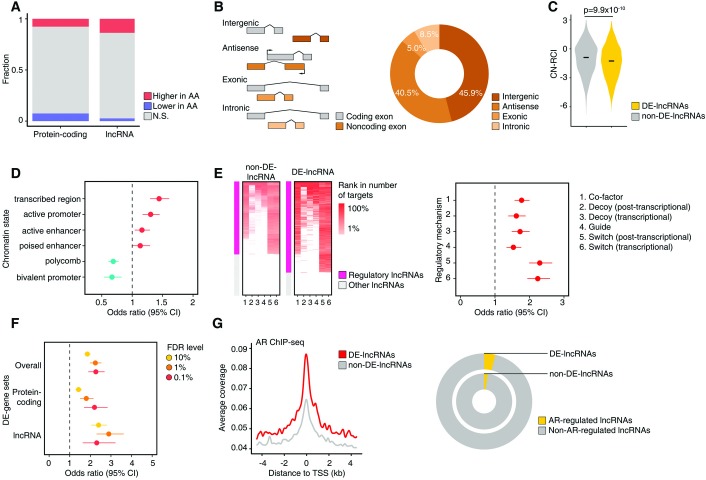
Comparison of the prostate tumor non-coding transcriptome by genetic ancestry.(A) Proportions of DE-protein-coding and DE-non-coding genes. Red indicates statistically significantly higher expression in AA, while blue indicates lower expression in AA. Width of bars is proportional to the number of genes. (B) Classification of lncRNAs by genomic location relative to protein-coding genes (left). Circle plot of distribution of DE-lncRNAs by lncRNA genomic location (right). (C) Distributions of cytoplasmic-nuclear relative concentration index (CN-RCI) for DE-lncRNAs and non-DE-lncRNAs. DE-lncRNAs are more enriched in the nucleus (lower CN-RCI). (D) Odds ratios and 95% confidence intervals (95% CI) of differential expression by genetic ancestry of lncRNAs by chromatin state of the genomic region. Chromatin state is estimated by ChromHMM partitioning of the LNCaP cell. (E) Heatmap displaying enrichment for regulatory lncRNAs among non-DE-lncRNAs and DE-lncRNAs by regulatory mechanism (left). Odds ratios (95% CI) of differential expression by genetic ancestry of lncRNAs by regulatory mechanism (right). (F) Odds ratios (95% CIs) of enrichment with genes regulated by normal prostate tissue eQTLs (eGenes) for DE-genes overall, DE-protein-coding genes, and DE-lncRNAs. Odds ratios are displayed by FDR level of the differentially expressed gene. (G) Average signals of AR binding at transcription start sites (TSSs) of DE-lncRNAs (red) and non-DE-lncRNAs (gray) from AR ChIP-seq data from VCaP cell (left). Circle plot showing proportion of AR-regulated lncRNAs among DE-lncRNAs and non-DE-lncRNAs (right). AR regulation was inferred by analysis of DHT-stimulated transcriptome.